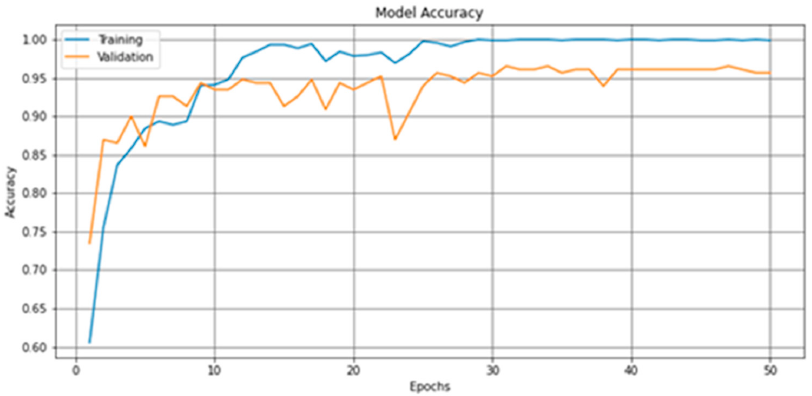
Figure 6. The accuracy graph produced by the deep-learning method described in Section 2.2.2 and